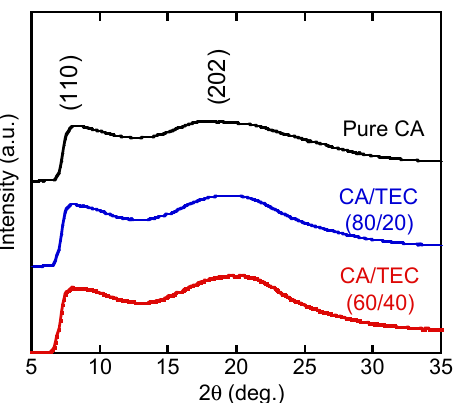
Figure 3. WAXD profiles of the CA and CA/TEC films. The numerals in brackets represent the Miller indices.